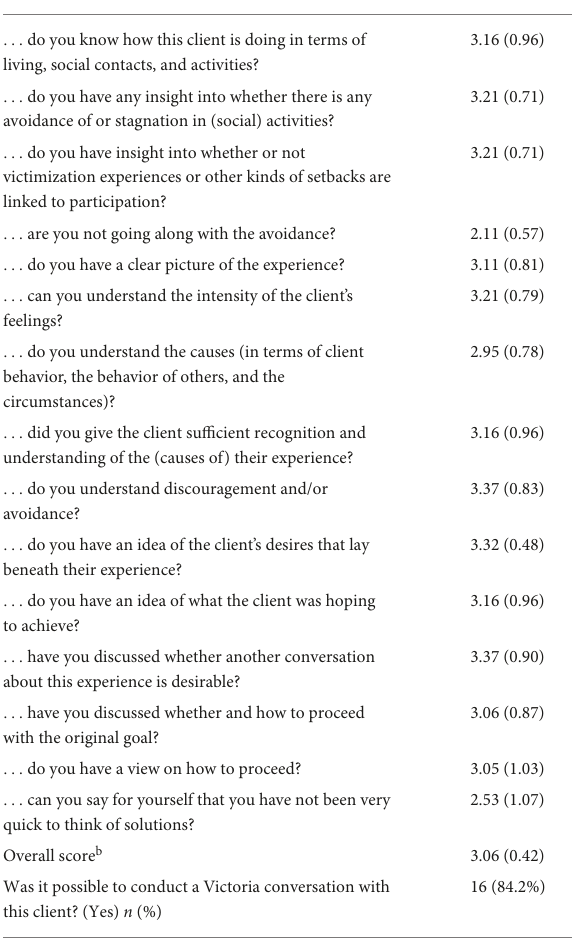
TABLE 4 Checklist of the steps of the